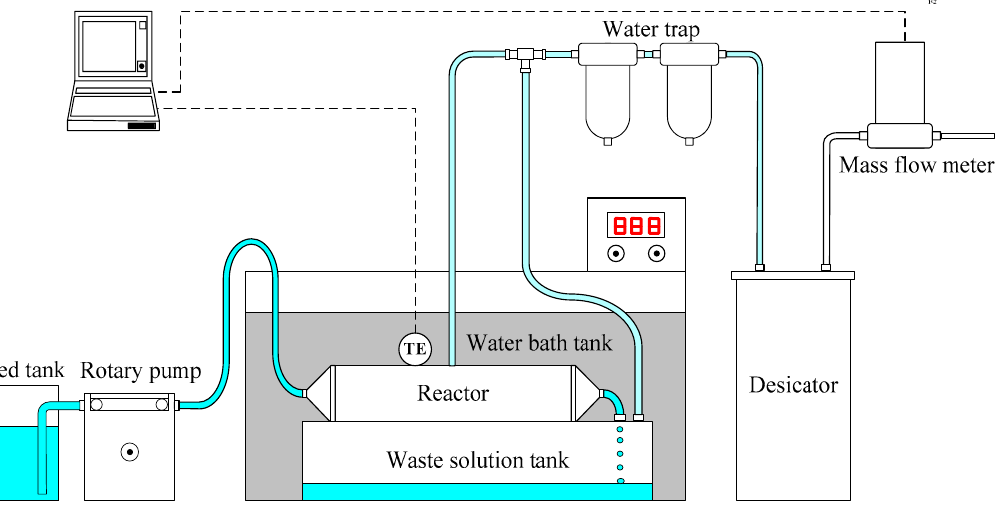
Figure 1. Experimental flow diagram of a sodium borohydride hydrolysis reaction for hydrogen generation.